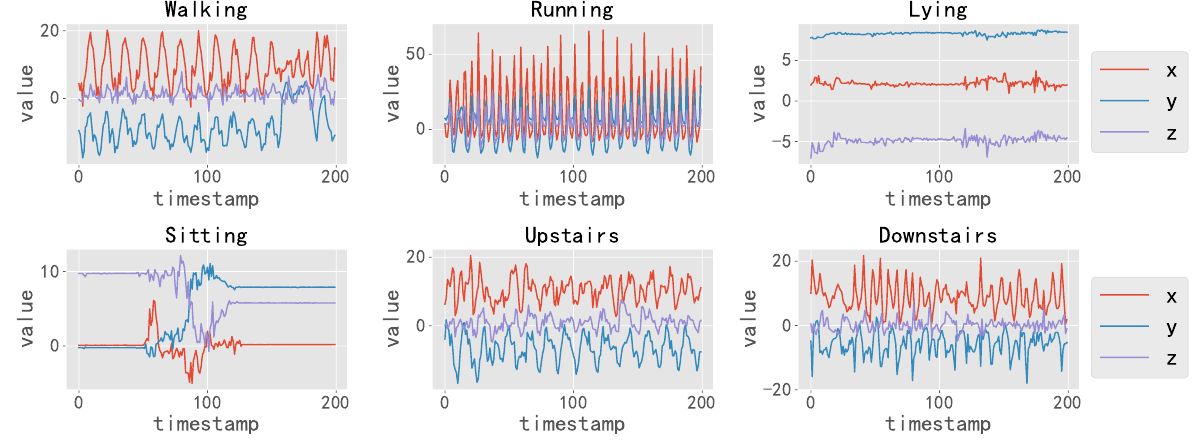
Figure 2. Accelerometer data for different behavior states.